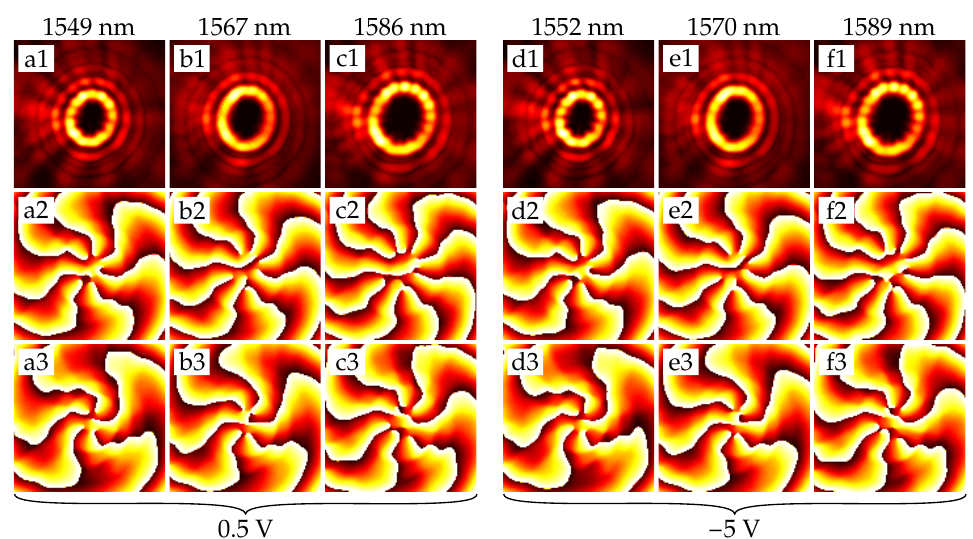
Figure 5. Intensity and phase distributions of the emitted fields from the ring with radius 5.5 µm. ( a1 – a3 ) is an intensity, arg ( E x ) and arg ( E y ) at a given resonant wavelength, respectively. Phase distributions are obtained after passing the field through the quarter-wave plate, so its x -component’s azimuthal order is above by one, and its y -component’s azimuthal order is below by one than the actual order of the generated vector vortex beam. Distribution patterns ( b1 – b3 )–( f1 – f3 ) are obtained similarly. ( a1 – a3 ), ( b1 – b3 ), and ( c1–c3 ) refer to the resonances at the voltage of 0.5 V, and ( d1 – d3 ),